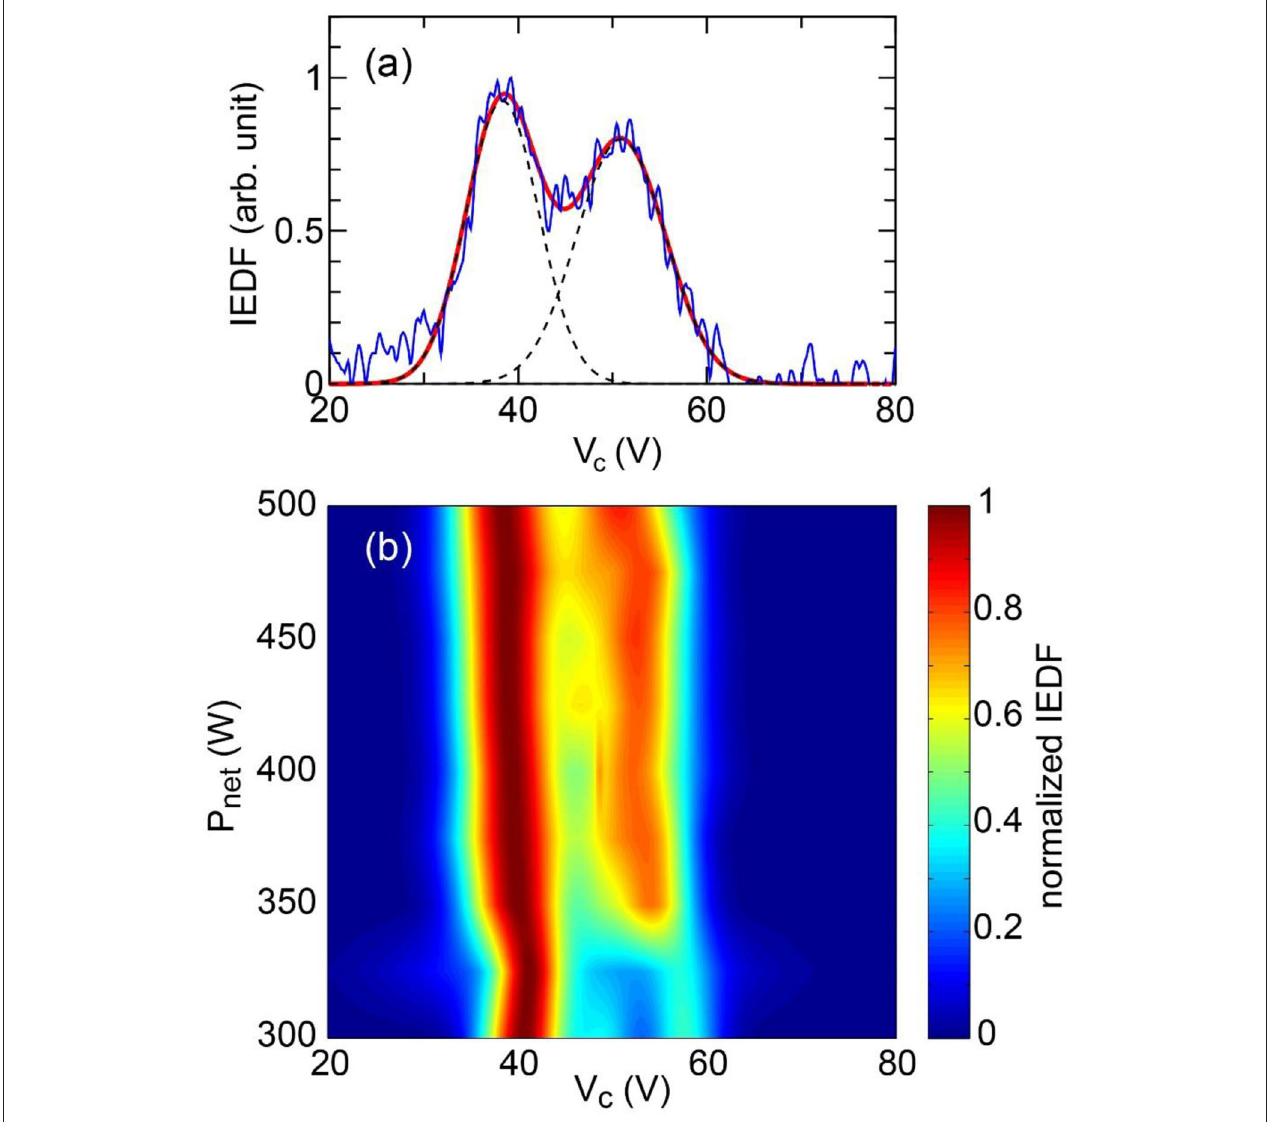
FIGURE 7 | (a) IEDF (a blue solid line) taken at z = 25cm together with the Gaussian fitting curve (a red solid line) given by the sum of the two Gaussians drawn by dashed lines, where the gas flow rate and the net rf power are chosen as 70 sccm and 500W, respectively. (b) Contour plot of the normalized IEDF as a function of the net rf power P net , where the Gaussian fitting curves are used to draw the contour